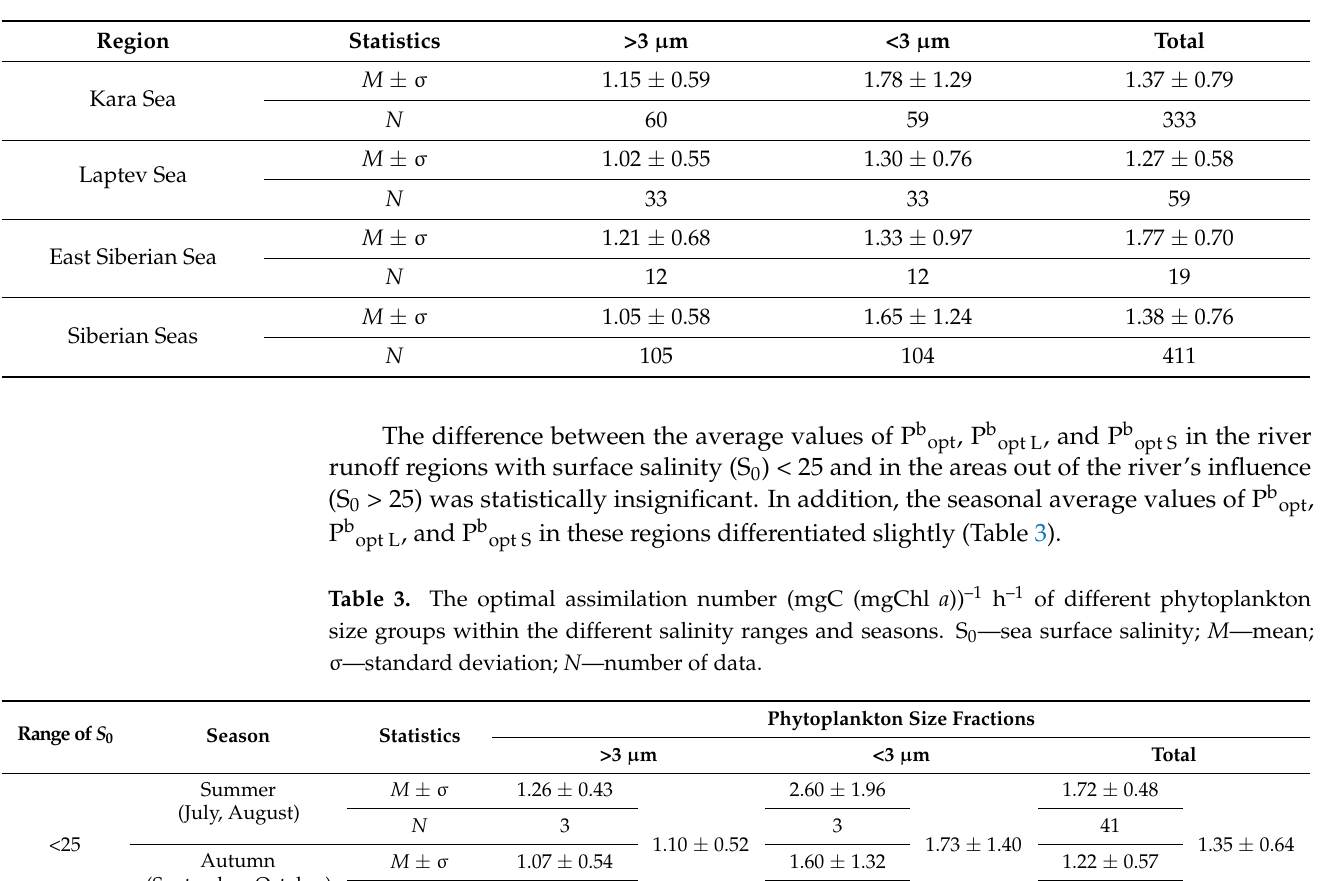
Table 2. The variability in the optimal assimilation number (mgC (mgChl a )) –1 h –1 of different phytoplankton size groups in the Siberian Seas. M —mean; σ —standard deviation; N —number of data.